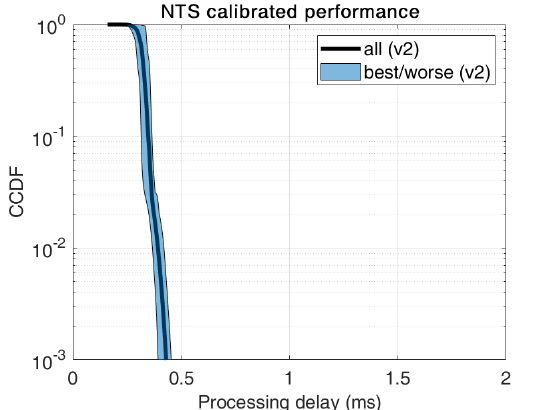
Figure 5. CCDF of the processing delay introduced by the NTS device in operational